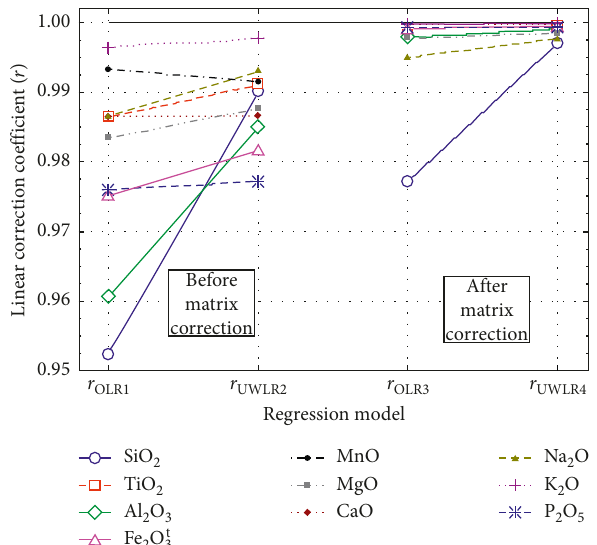
Figure 1: Linear correlation coefficient ( r ) values for the ordinary least-squares linear regression (OLR) and uncertainty-based weighted least-squares linear regression (UWLR) models for the XRF calibration of major elements (SiO 2 to P 2 O 5 ) in rocks and minerals. OLR1: OLR model 1 for Int-Conc before matrix cor- rection; UWLR2: UWLR model 2 for Int-Conc before matrix correction; OLR: OLR model 3 for ConcCalc-Conc after matrix correction; and UWLR4: UWLR model 4 for ConcCalc-Conc after matrix correction. Symbols are shown as inset. The horizontal line at the r value of 1 represents the “ideal” or “perfect” linear